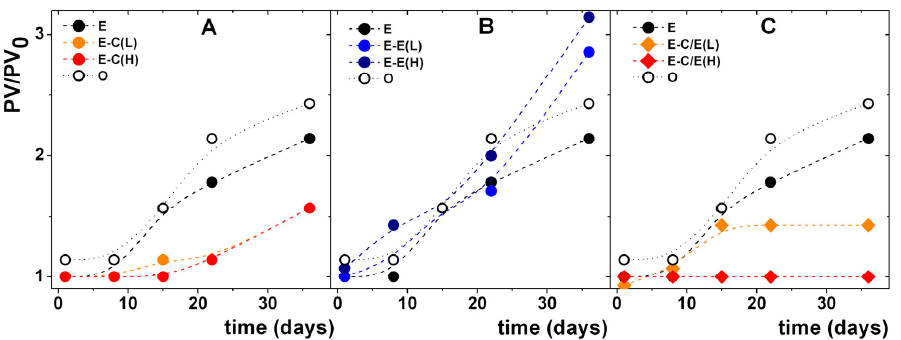
Figure 6. Relative PV variations for ( A ) vitamin C enriched emulsions compared with E and O; ( B ) vitamin E enriched emulsions compared with E and O; ( C ) vitamin C and vitamin E enriched emulsions compared with E and O.